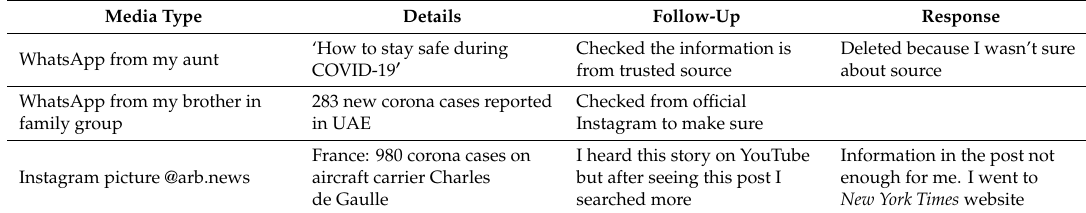
Table 5. Examples of inter-platform